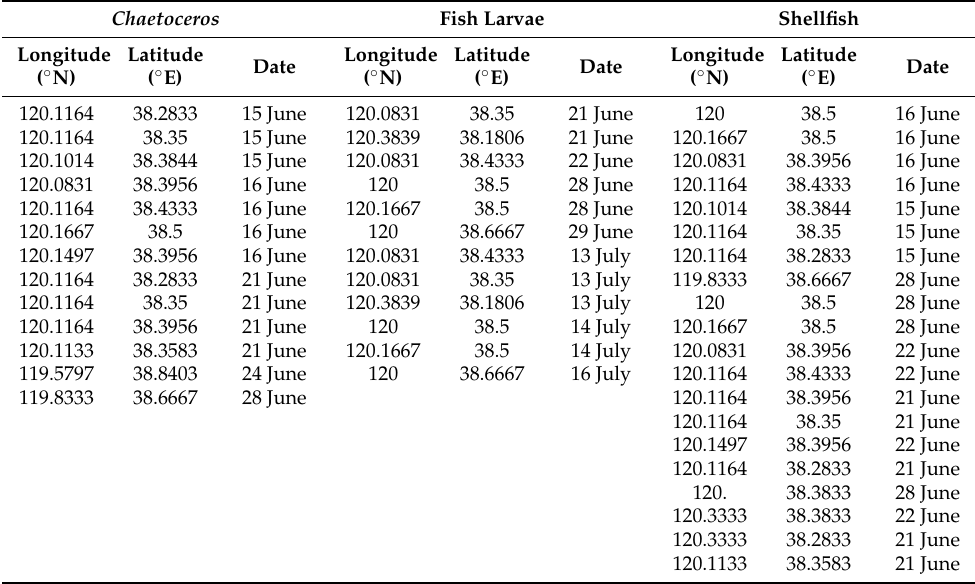
Table 1. Observation information of Chaetoceros , fish larvae and shellfish: location and date. Chaetoceros Fish Larvae